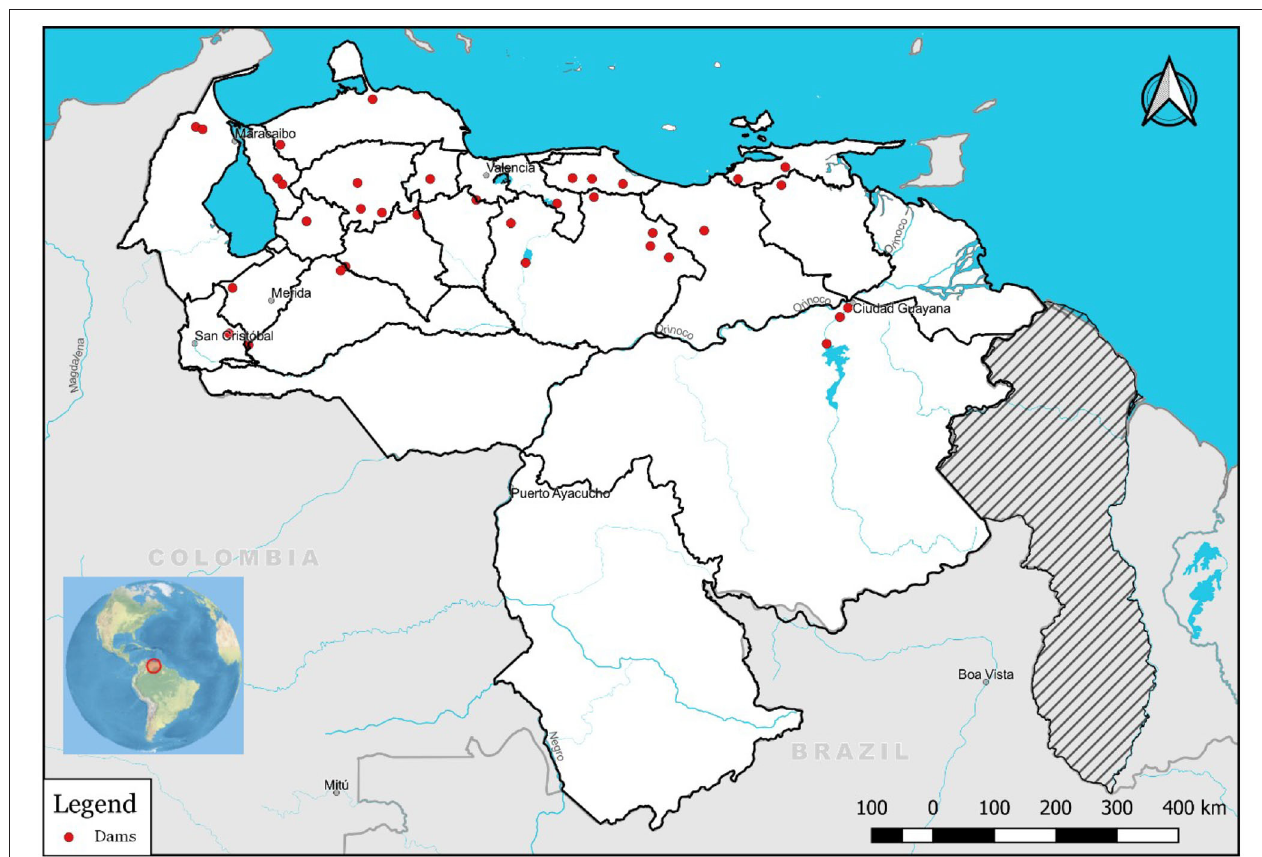
FIGURE 3 | Distribution the meaning Dams in Venezuela.